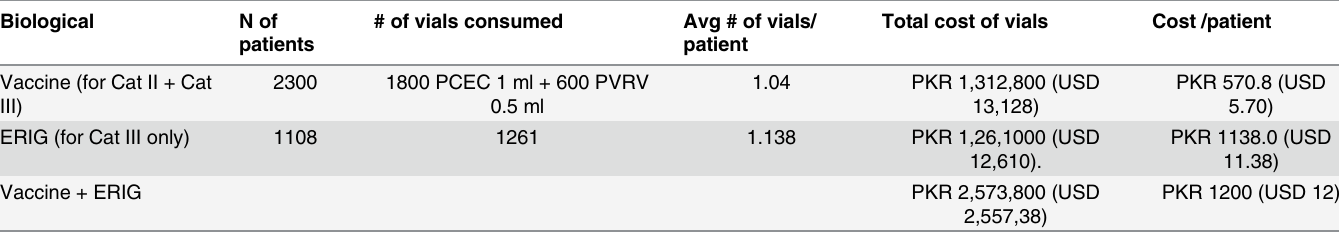
Table 2. Consumption and cost of biologicals for Rabies PEP July 2013 to June 2014 at TIH. Biological